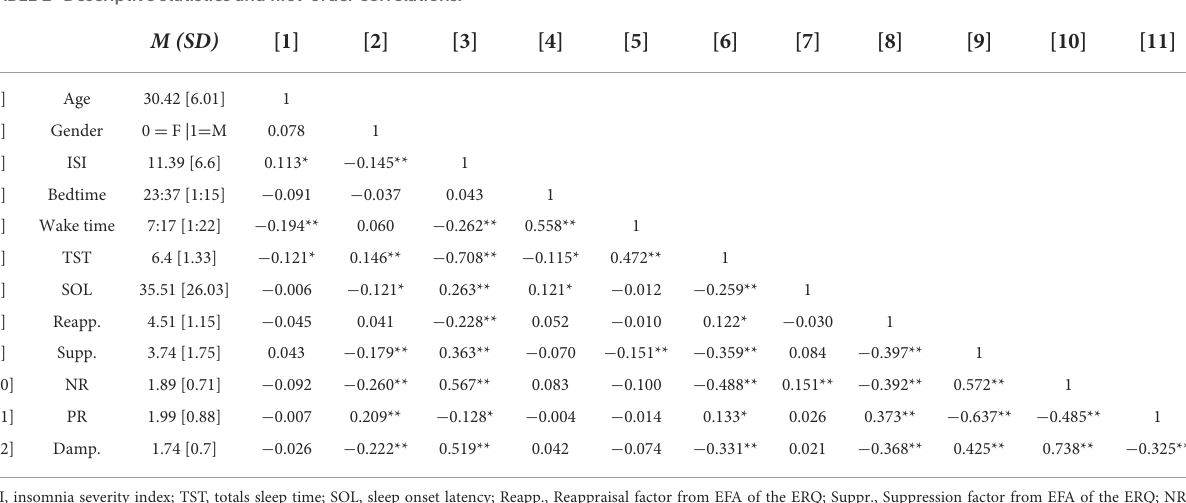
TABLE 2 Descriptive statistics and first-order correlations.